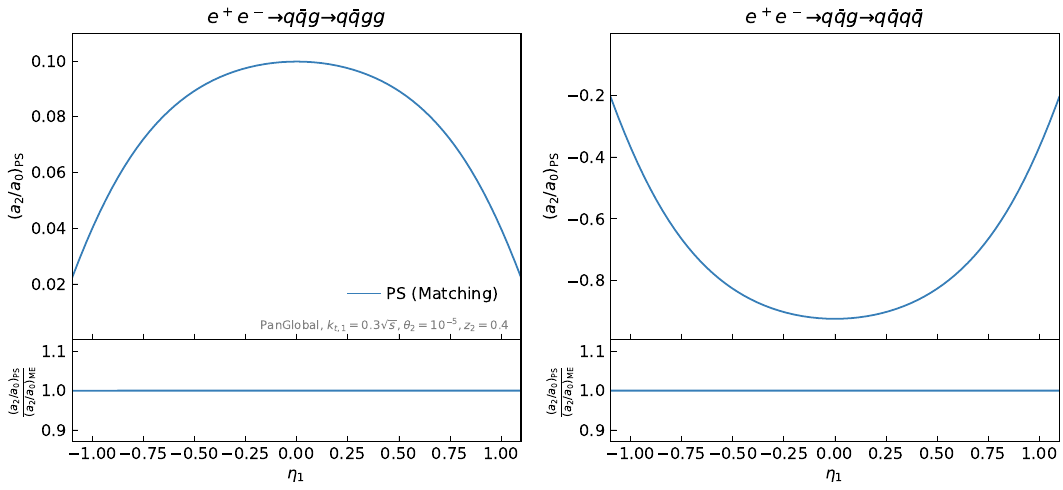
Figure 13. Second-order validation of the implementation of spin correlations in the hard region for e + e − → γ ∗ → q ¯ q . Following eq. (B.14), the ratio a matching enabled (blue curve). Below, the ratio of the shower a a 2 /a 0 is